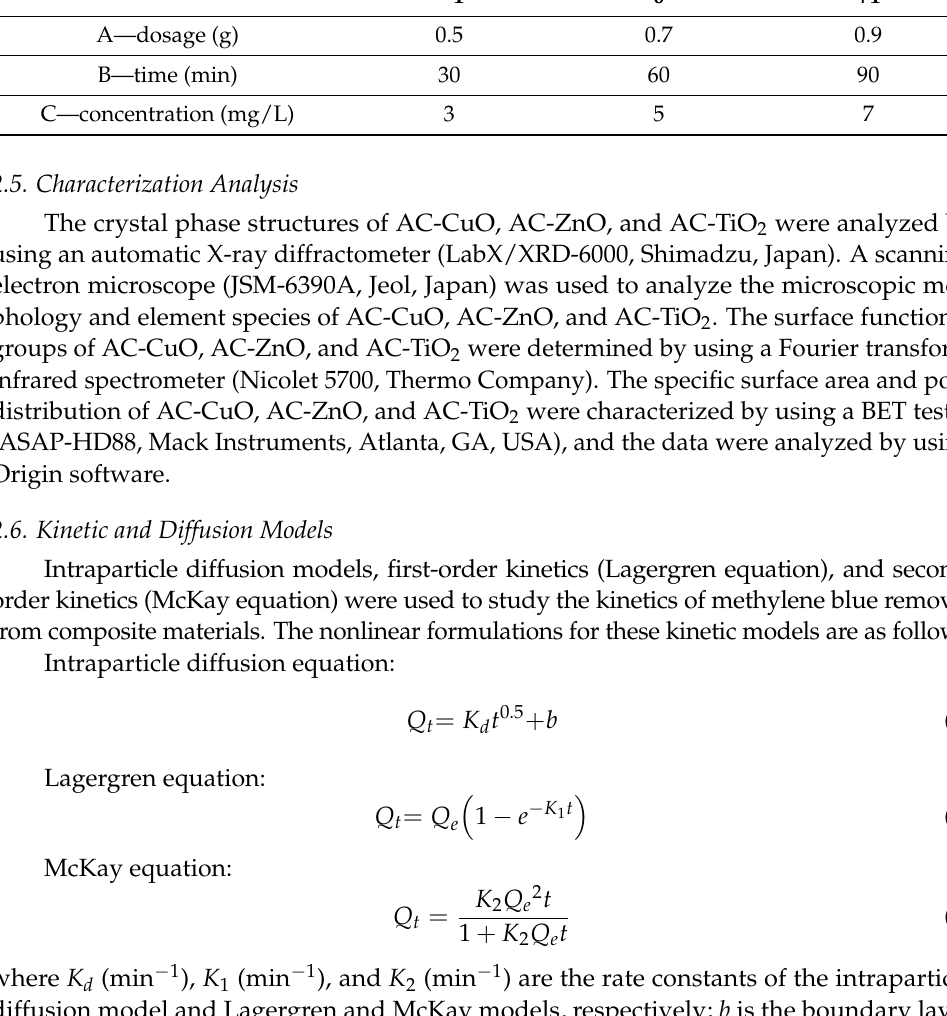
Table 1. The experimental range and level of independent variables. Factor A—dosage